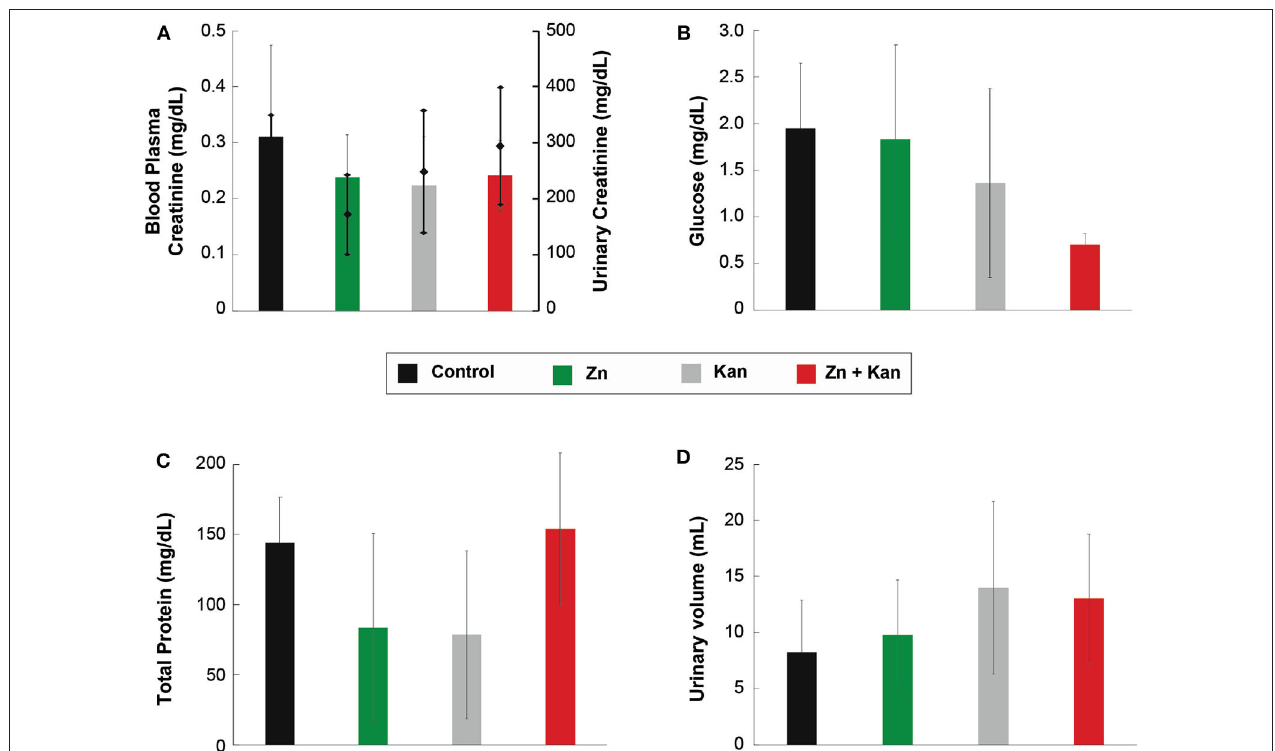
FIGURE 9 | Effect of Zn-kanamycin combination on the function of kidney in male Wistar rats. (A) Urinary (diamonds) and blood plasma (bars) creatinine levels. (B) Urinary glucose levels. (C) Total urine proteins. (D) Urinary volume. All experiments were tested in groups of n = 5 for 3 days. Error bars represent ± SD.